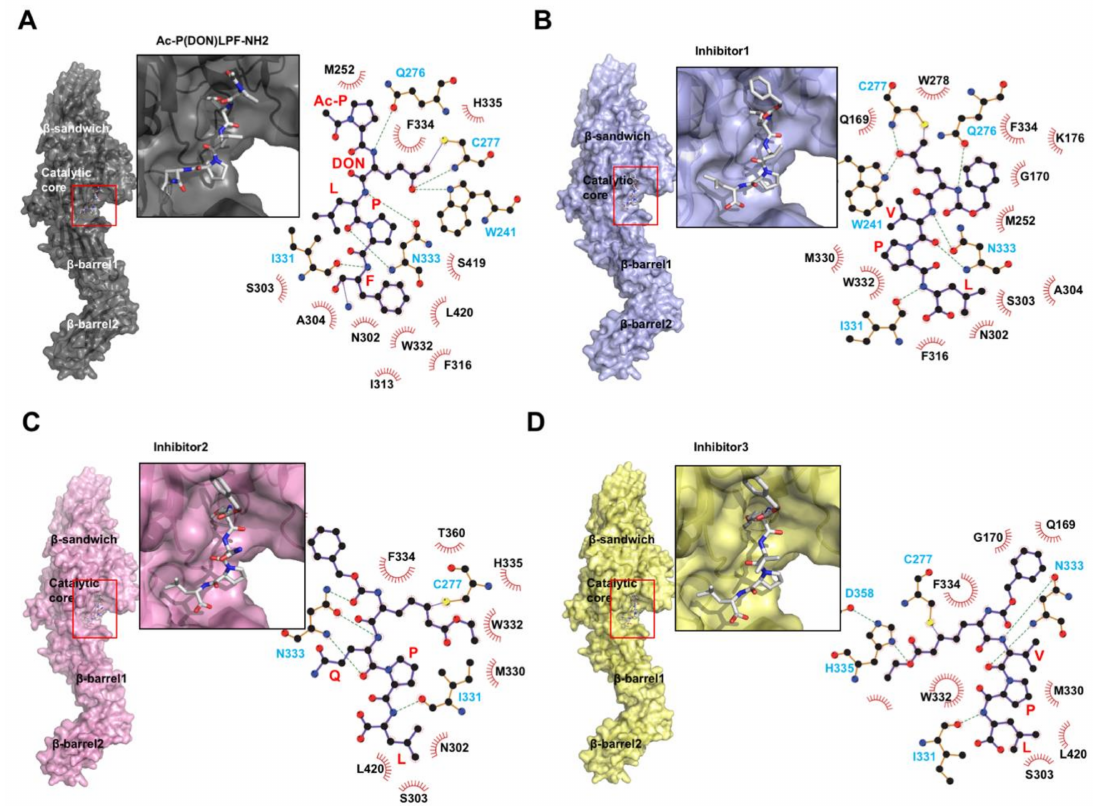
Figure 3. Structural analysis of TGase2 complexed with peptide mimetic inhibitors. Structure of TGase2 complexed with peptide mimetic, Ac-P(DON)LPF-NH2 ( A ), with peptide inhibitor1, N-[(benzyloxy)carbonyl]-6-diazonio-5-oxo-L-norleucyl-L-valyl-L-prolyl-L-leucine ( B ), with peptide inhibitor2, N~2~-[(2S)-2-{[(benzyloxy)carbonyl]amino}-7-ethoxy-7-oxoheptanoyl]-L-glutaminyl-L-prol yl-L-leucine ( C ), and with peptide inhibitor3, N-[(2R)-2-{[(benzyloxy)carbonyl]amino}-7-ethoxy-7-oxohe ptanoyl]-L-valyl-L-prolyl-L-leucine ( D ). The red box indicates the inhibitor-binding site. The magnified figure of the inhibitor in the inhibitor-binding site of TGase2 is provided. The binding details, generated by LIGPLOT + [80], are shown at the right side of each panel. The black and cyan residues indicate the hydrophobic interaction and hydrogen bond,